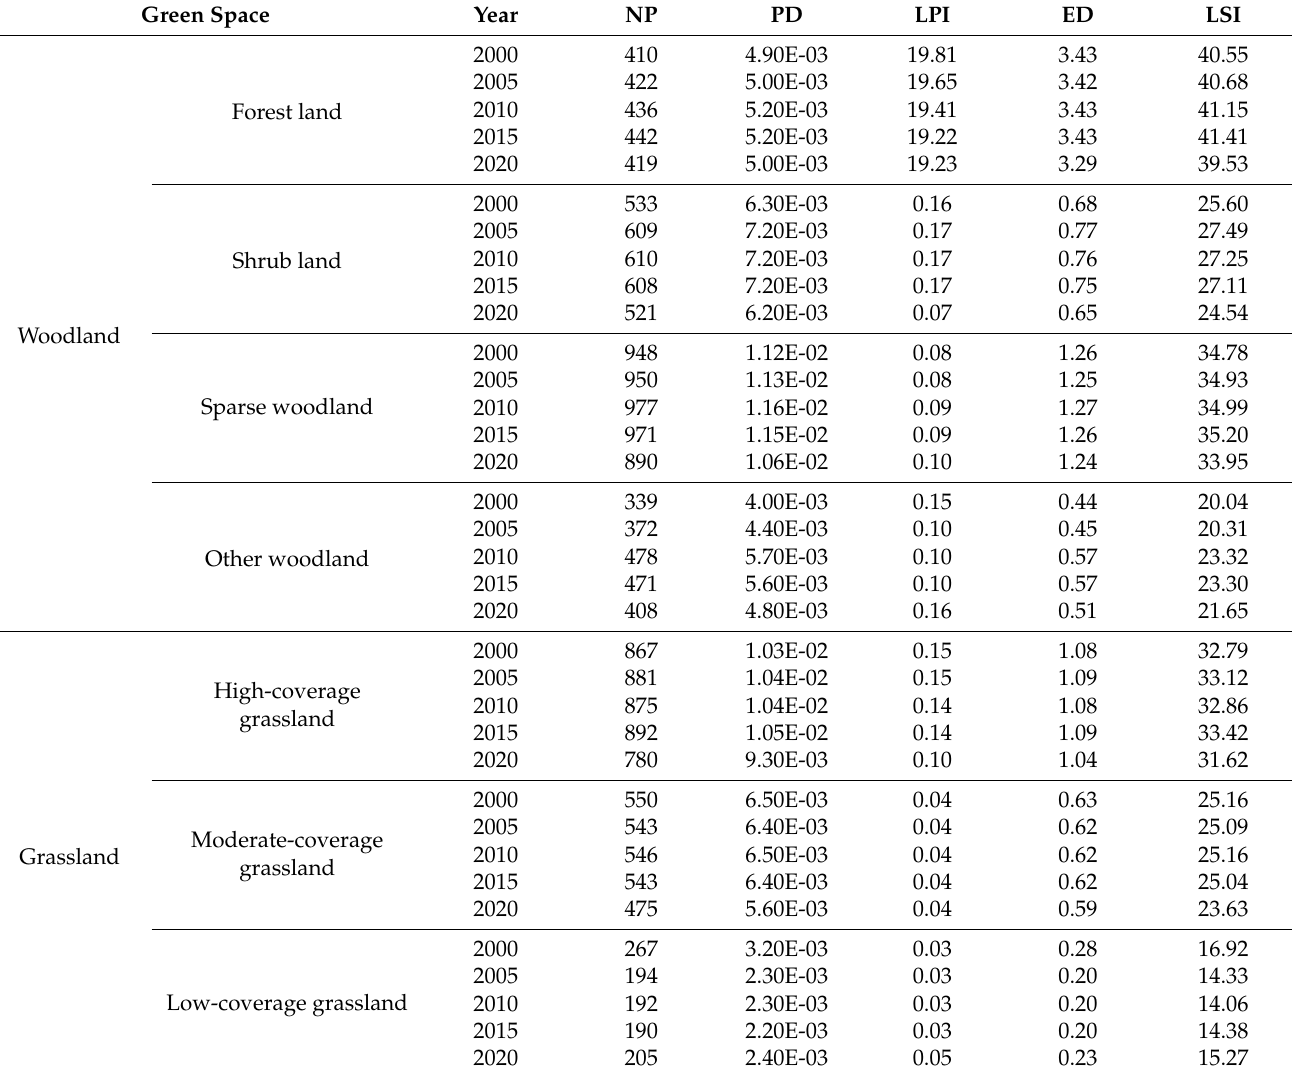
Table 5. The change of landscape pattern index of seven sub-types of green space in coastal cities of southeast China over the past 20 years. NP, PD, LPI, ED and LSI are number of patches, patch density, the largest patch index, edge density and landscape shape Index,